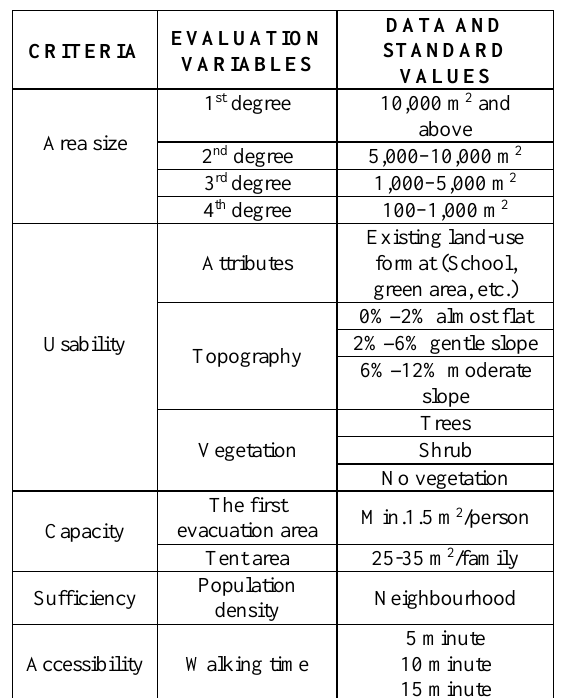
Table 2. The analysis elements of shelter areas